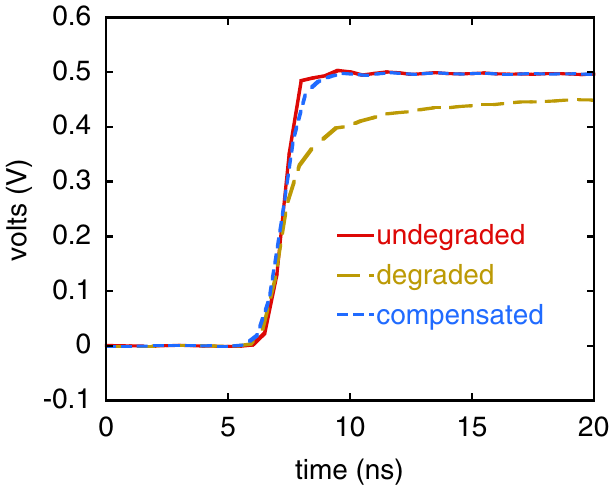
FIG. 17. (Color) Result of a numerical cable compensation [79] that is performed using a step-function voltage pulse. The un- degraded pulse has a 10%–90% rise time of 1.3 ns and a peak voltage of 0.5 V. When the pulse is transported through the coaxial-cable system delineated by Table II, the pulse suffers a significant reduction of its high-frequency components. Both the undegraded and degraded pulses are used to generate a decon- volution function for the coaxial-cable system [79]. The numeri- cally compensated pulse plotted above is obtained by deconvolving the degraded pulse [79]. (The waveforms have been time shifted to facilitate